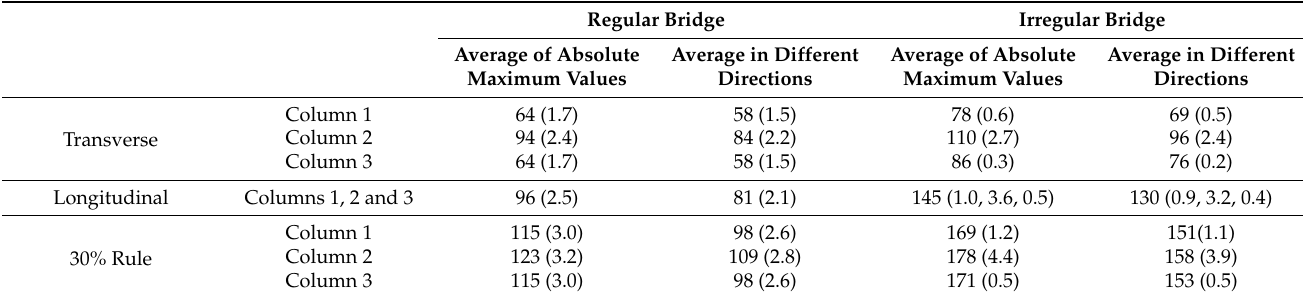
Table 3. Summary of the mean displacements (mm) of columns using 2D analysis for the regular and irregular bridges with mean ductility demands given in brackets.